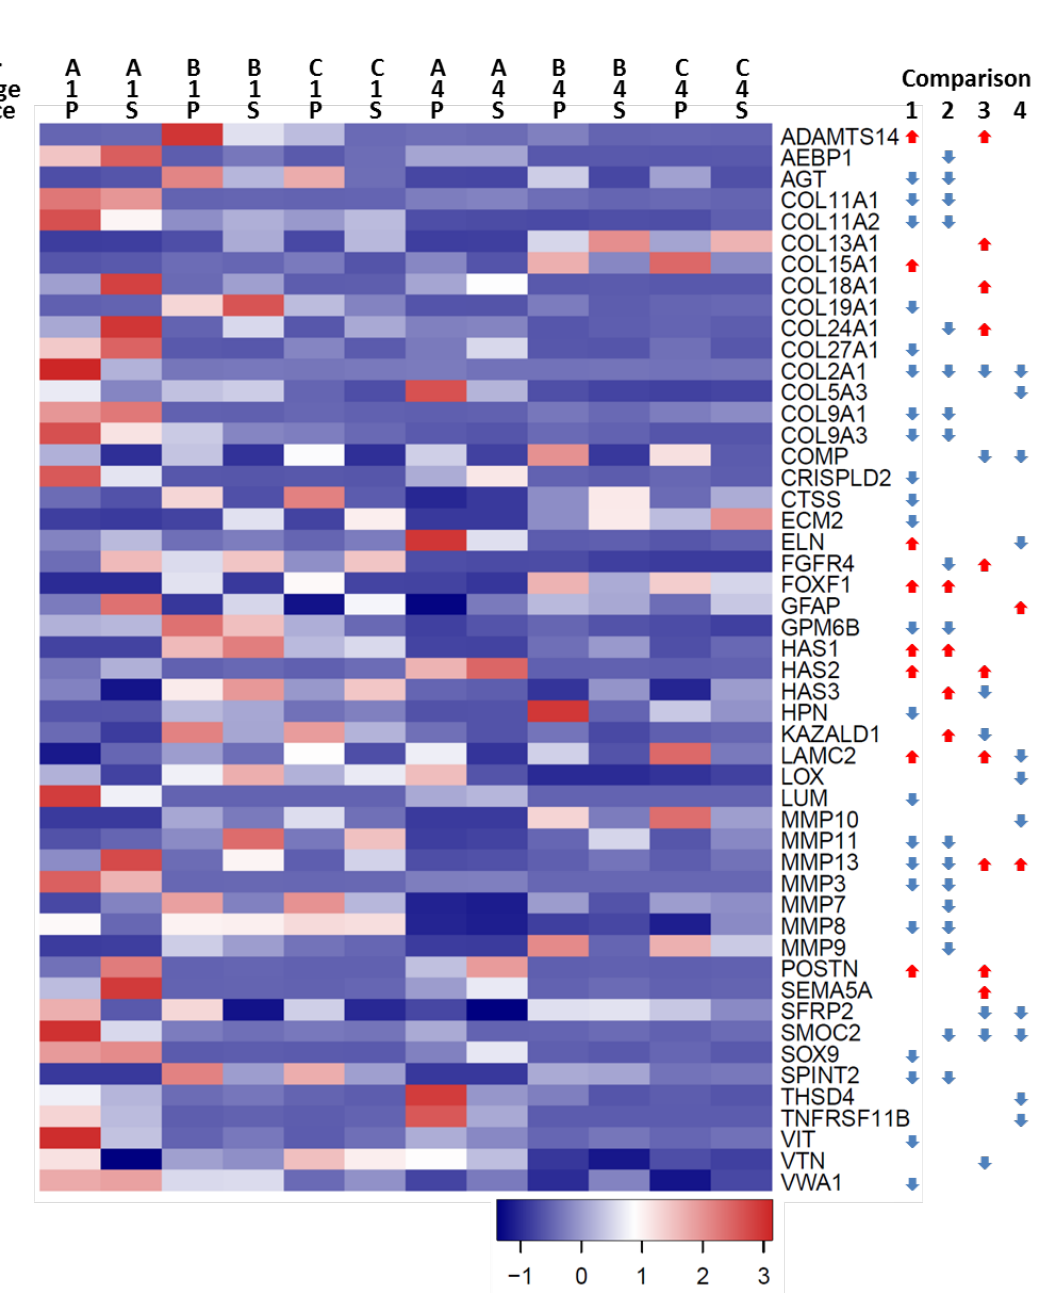
Figure 5. Differentially expressed extracellular matrix organization genes. This heatmap shows differentially expressed genes from the four comparisons which are associated with the GO term “extracellular matrix organization”. Donor (A, B, C), passage (1, 4) and surface (P = TCP and S = SDECM) are indicated at the top of the heatmap. The gene symbol is to the right of the heatmap. The arrows indicate which comparisons were significantly different at a ≥ 4-fold change with p < 0.01; no arrow means that the comparison did not meet that threshold (1 = TCP P1 vs. P4, 2 = SDECM P1 vs. P4, 3 = TCP vs. SDECM at P1, 4 = TCP vs. SDECM at P4). A red arrow pointing upwards ( ) indicates